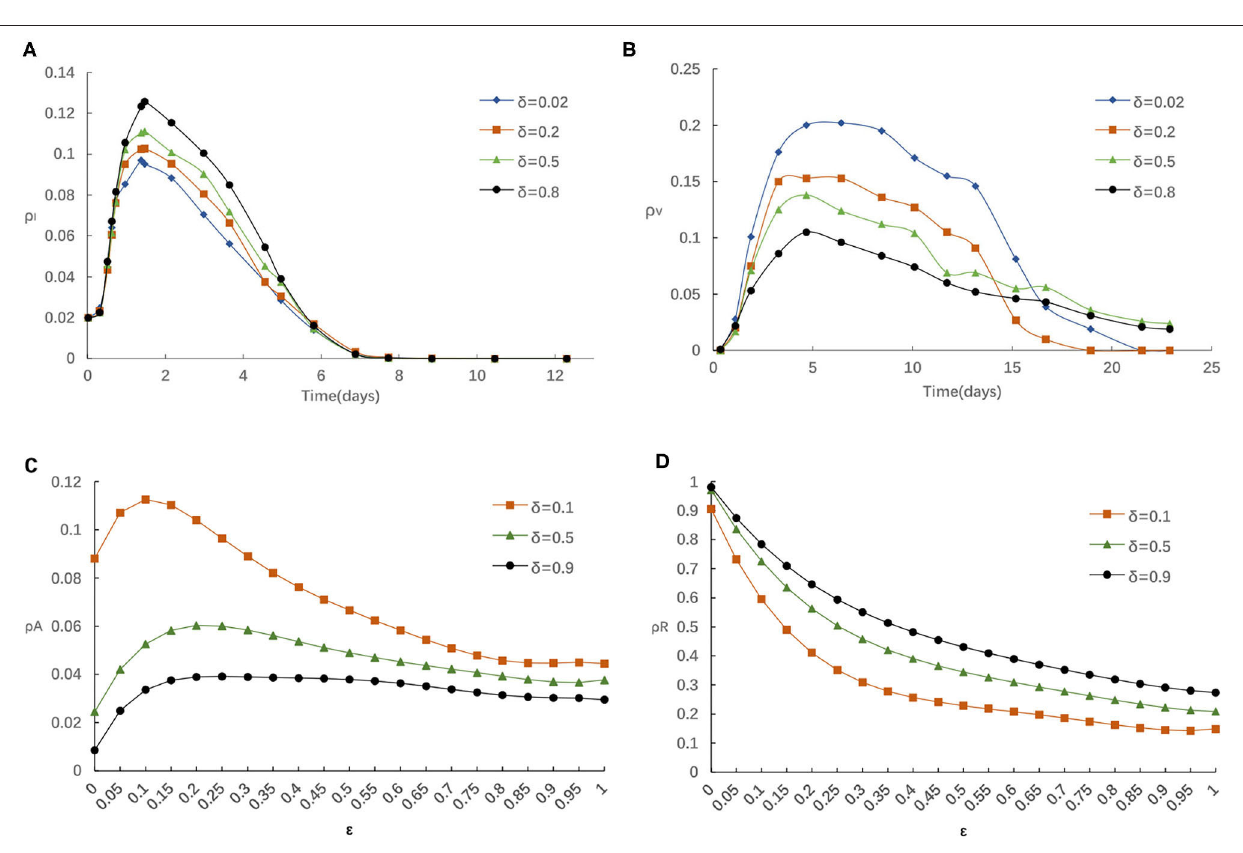
FIGURE 6 | (A) The fraction of infected for various δ with η = 0.05, α = 0.3, α 0 = 0.2. (B) The fraction of vaccinated for various δ with η = 0.05, α = 0.3, α 0 = 0.2. (C) The fraction of aware for various δ with η = 0.05, α = 0.3, α 0 = 0.2. (D) The fraction of recovered for various δ with η = 0.05, α = 0.3, α 0 =